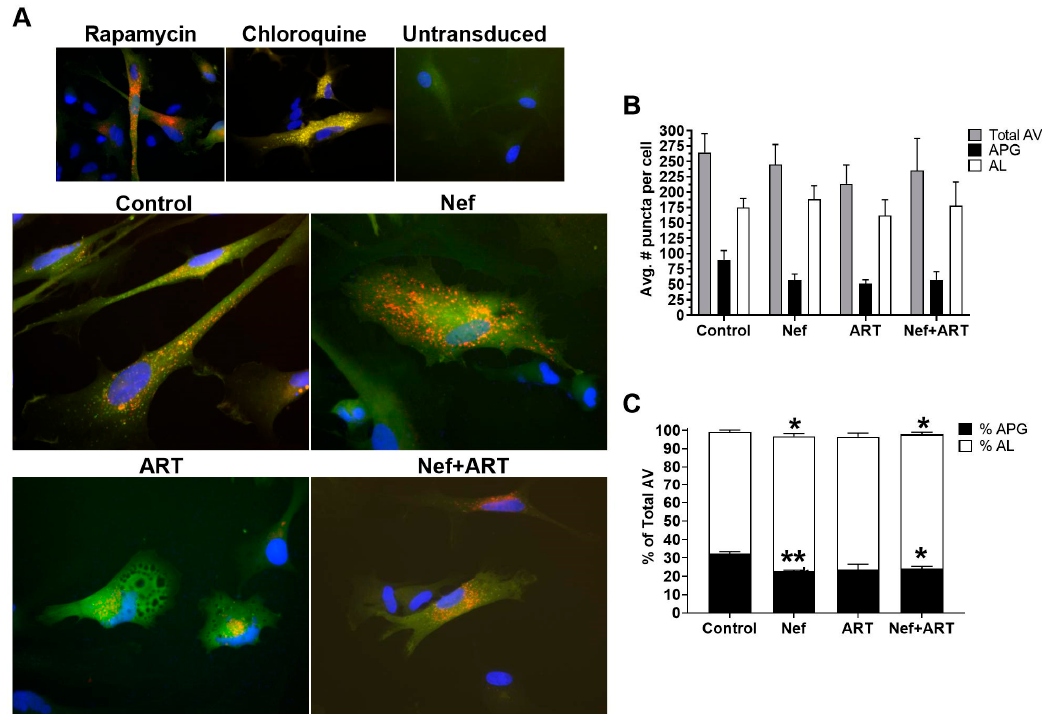
Figure 2. Autophagic vesicles (AV) after treatment with Nef and/or ART. Primary human astrocytes were transduced with a lentivirus expressing the mCherry–GFP–LC3 autophagy reporter, and treated with rapamycin for 16 h, chloroquine for 4 h, or with extracellular Nef and/or ART for 24 h. Red and green puncta were analyzed as described in Methods. ( A ) Representative images from transduced and treated cells, and untransduced cells. ( B ) The mean number of puncta per cell in control, Nef, ART, and Nef+ART treated cells. ( C ) Mean percent APG and AL of total AV in control, Nef, ART, and Nef+ART treated cells. Error bars represent SEM. n = 3 independent experiments, with a total of 189–229 cells per condition analyzed; *, p < 0.05; **, p < 0.005 by the Wilcoxon Matched-Pairs Signed Rank test.